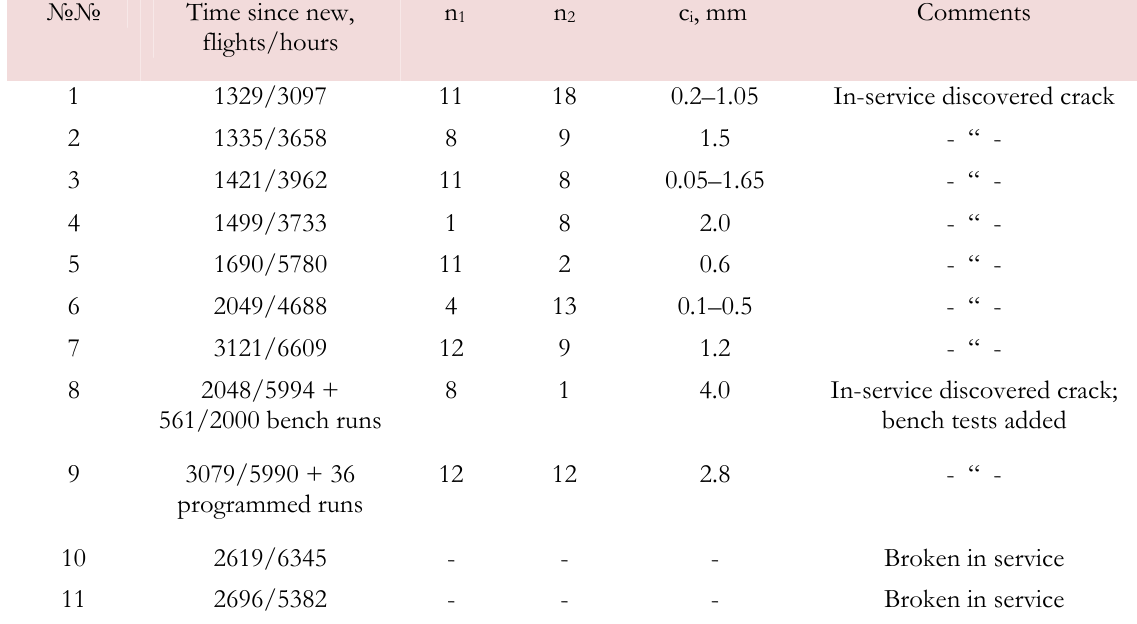
Table 1: In-service operation time of NK8-2u engines, numbers n 1 of the holes (see schema of the Fig.1) with cracks and n 2 of cracks in holes and crack size as measured by the